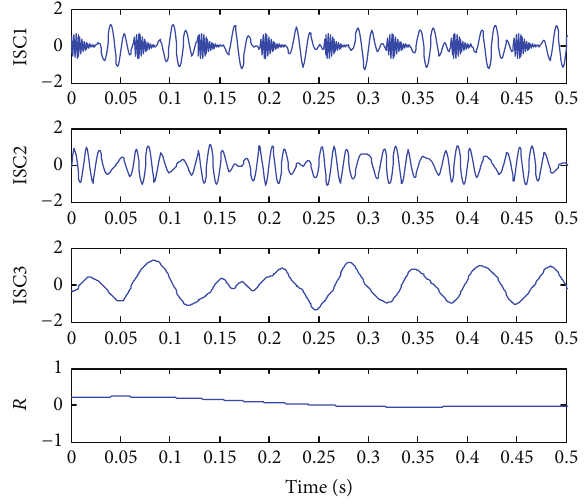
Figure 3: Simulation signal LCD results.